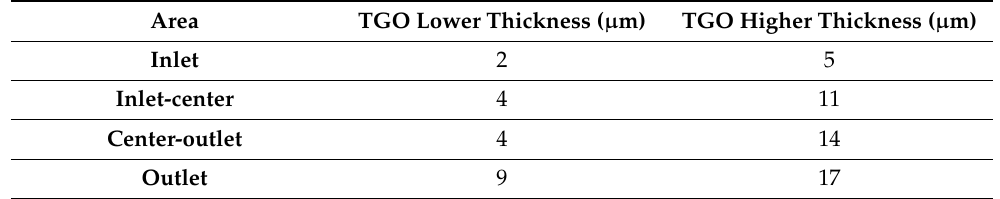
Table 3. TGO thicknesses measured at the air side.